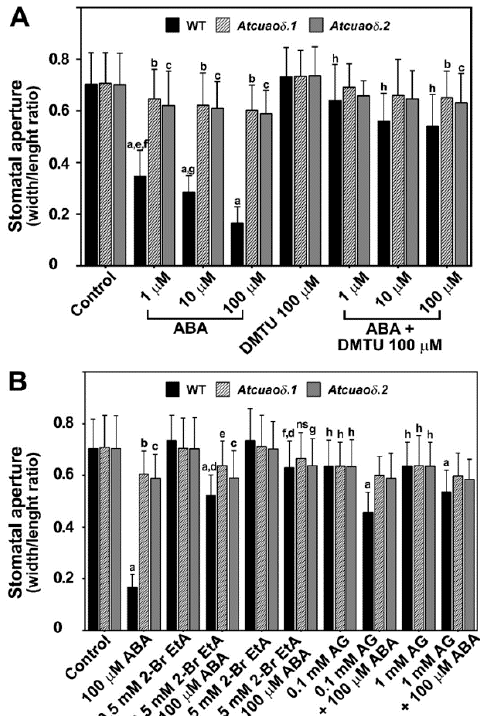
Figure 2. Effect of ABA, N,N ′ -dimethylthiourea (DMTU) ( A ) and CuAO inhibitors, 2-BrEtA and aminoguanidine (AG) ( B ), on stomatal pore width/length ratio of 12-day-old seedlings from WT, Atcuao δ .1 , and Atcuao δ .2. Mean values ± SD ( n = 15) are reported. P values have been calculated with